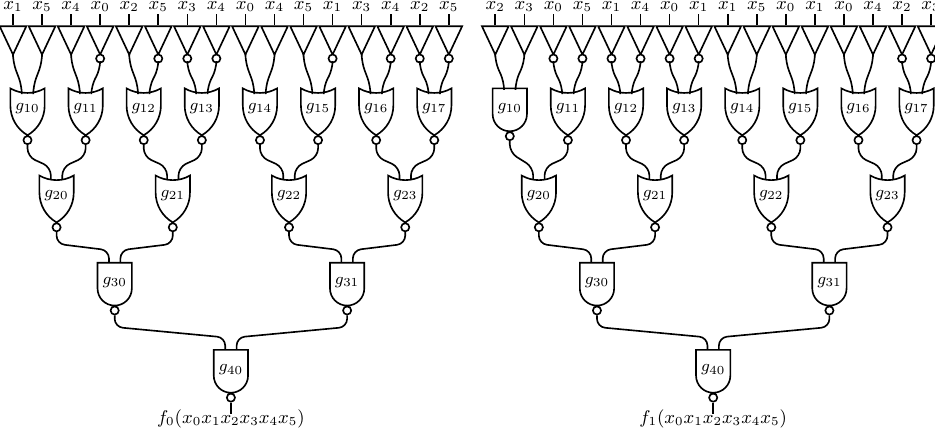
Figure 6: One of the possible low-latency structures for the representatives of the coordinate functions for 6-bit S-box in Example